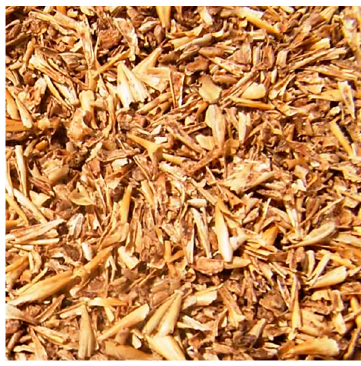
Figure 1. Sample of brewer’s grains.